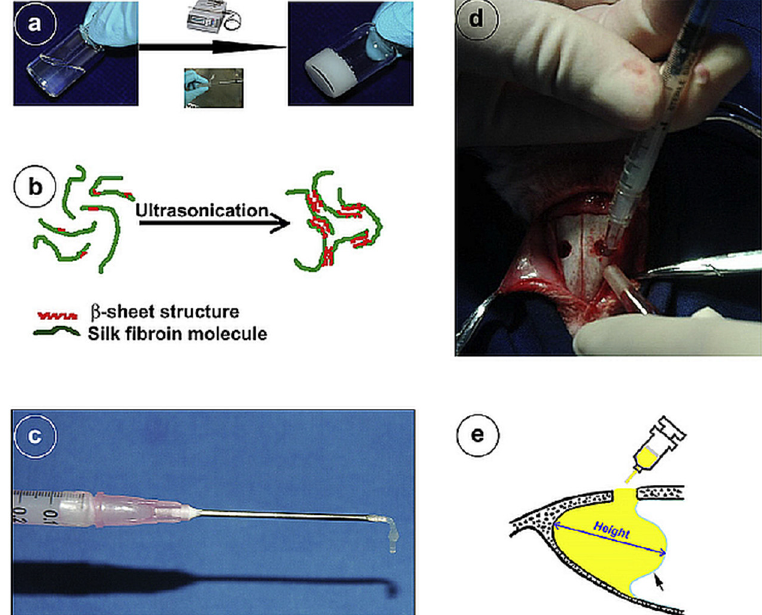
Figure 6. Sonication-induced silk fibroin hydrogel preparation. ( a ) Ultra-sonication procedure used for aqueous silk solution transformation into a solid silk hydrogel. ( b ) Schematic illustration of the mechanism of silk sol-gel transition due to physical crosslinking and β -sheet aggregate formation after ultra-sonication. ( c ) Injectable properties of the silk hydrogels. ( d ) Silk hydrogel being injected into rabbit maxillary sinus cavity. ( e ) Illustration of the elevated sinus in a sagittal plane being filled by the injected silk hydrogel. Reprinted from a previous study [179] with permission.